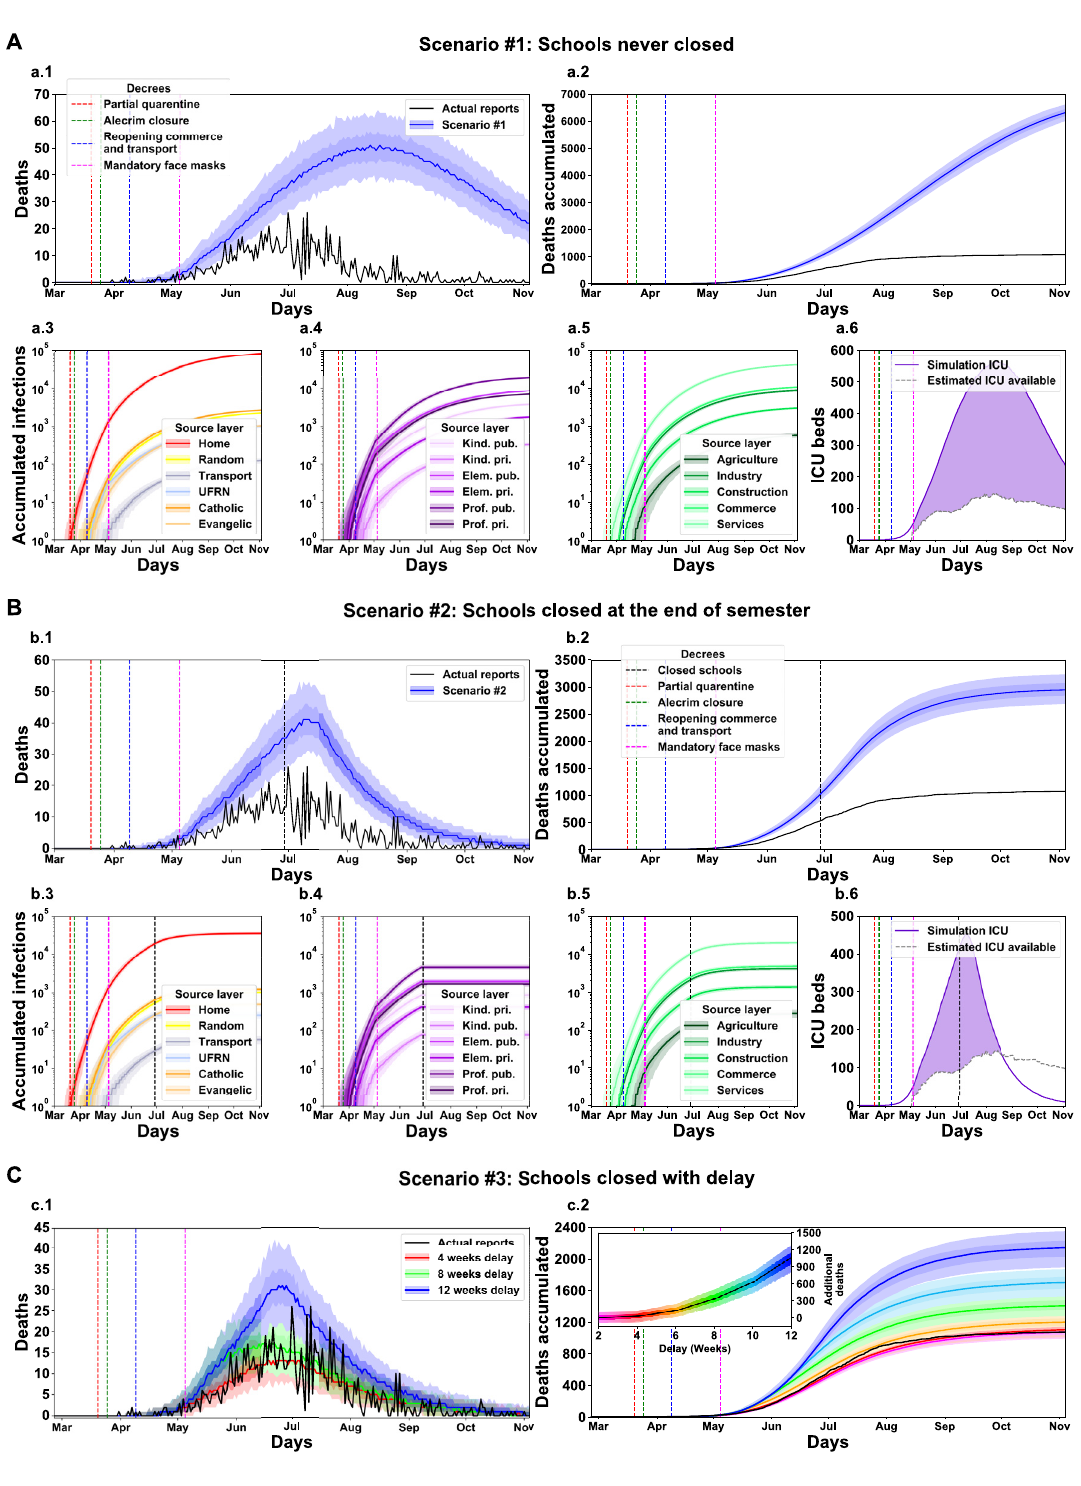
Fig 6. Simulation of different scenarios reveals a significant impact of the school closure decree on March 17th, 2020. Results for a baseline scenario altered for the condition that schools were never closed (#1, A), closed at the end of the semester (#2, B) and closed with a delay from the original decree’s publication date (#3, C). The total number of additional deaths in each scenario is the difference between the simulation outcome and the reported number. For scenario #3, the delay in weeks is colour-coded, and the additional number of deaths is shown in an insert. See Fig 5 for panel